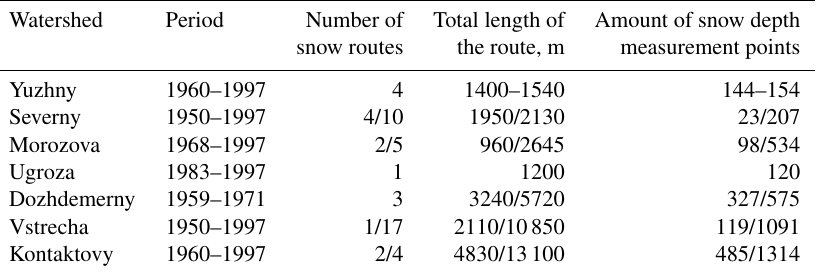
Figure 4. (a, b) Snow survey at the Kontaktovy creek catchment; (c) measurement of snow density, 1960 (photos from the KWBS archive, provided by S. I. Sushansky). Table 2. Number of snow routes, their total length and number of measurement points – maximum and minimum values within the whole period of